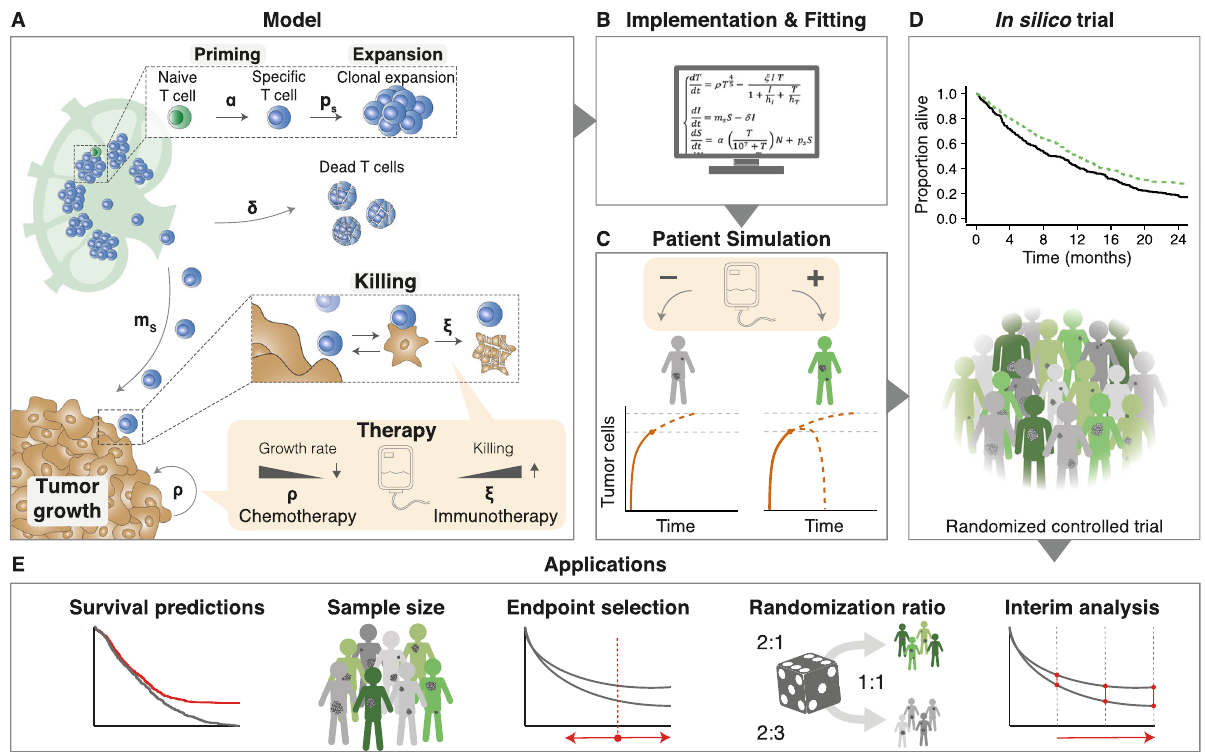
Fig. 1 | In silico late-stage immunotherapy trials and their applications. received either no treatment (placebo), chemotherapy, immunotherapy, or both. A Cellularinteractionsbetweenatumorandtheimmunesystemasimplementedin Disease trajectories based on tumor-immune dynamics were simulated for ODE model M1 (Methods). This model describes immunogenic tumor growth leading to a T cell response originating from lymph nodes. Disease courses in patients can be steered by immunotherapy, chemotherapy, or a combination of both. Parameters: α =naive T cell priming rate, δ =effector T cell death rate, ξ =effector T cell killing rate, ρ =tumor growth rate, ρ s =effector T cell proliferation rate, and m s =effector T cell migration rate. B After implementation, we used sur- vival data from clinical trials to fi t some of the model parameters. C Patients